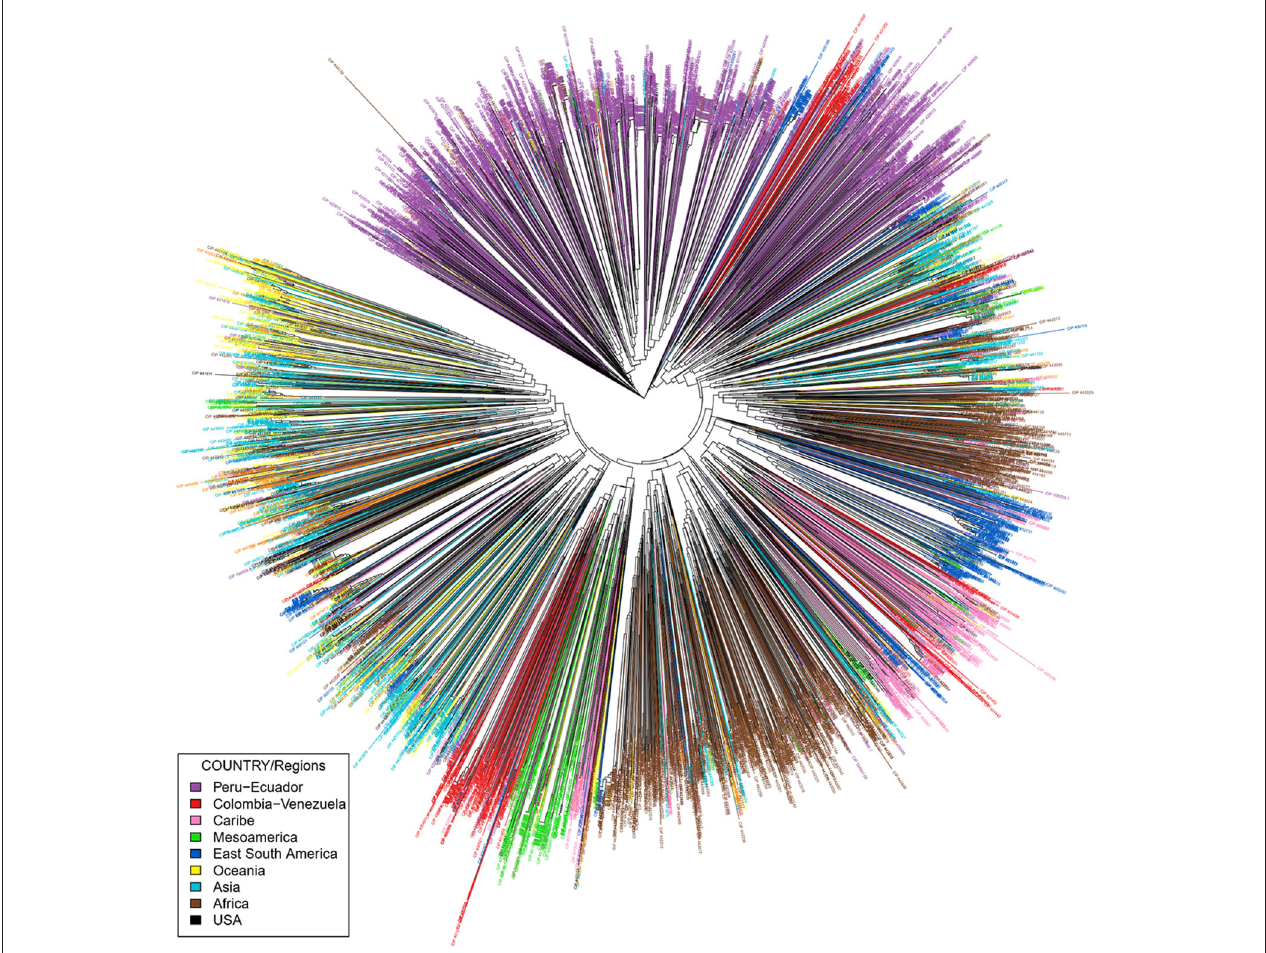
FIGURE 2 | Phylogenetic tree constructed with Neighbor Joining (NJ) of 5,979 sweetpotato accessions from the CIP germplasm collection. iTOL was employed to color code branches by country of origin or donation country. Peru = purple. Red = Venezuela and Colombia. Green = Mexico and Central America. Pink = Caribbean. Africa = brown. USA = black. Blue = Argentina, Paraguay, and Brazil. Turquoise = Asia. Yellow =